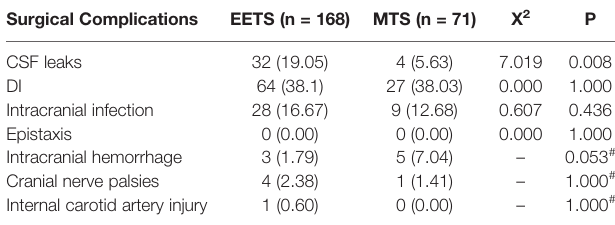
TABLE 6 | Complications comparison of ETTS and MTTS.